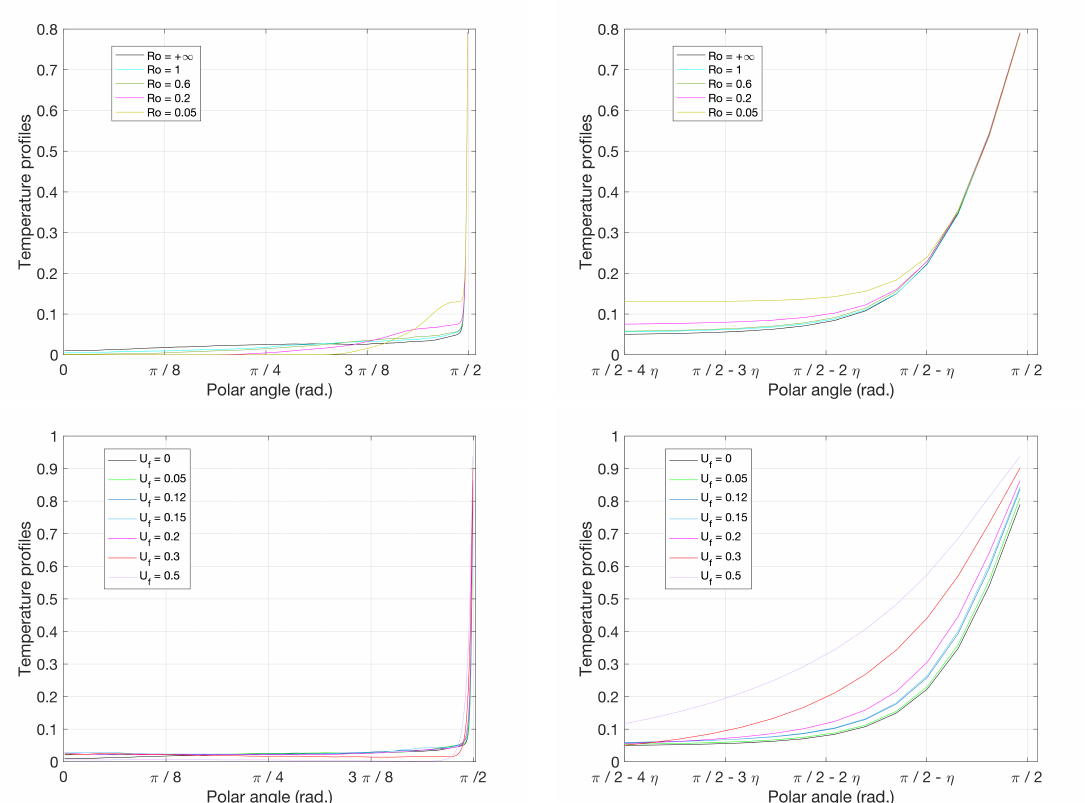
Figure 9. Temperature profiles. Top: Method 1 for various values of the Rossby number.